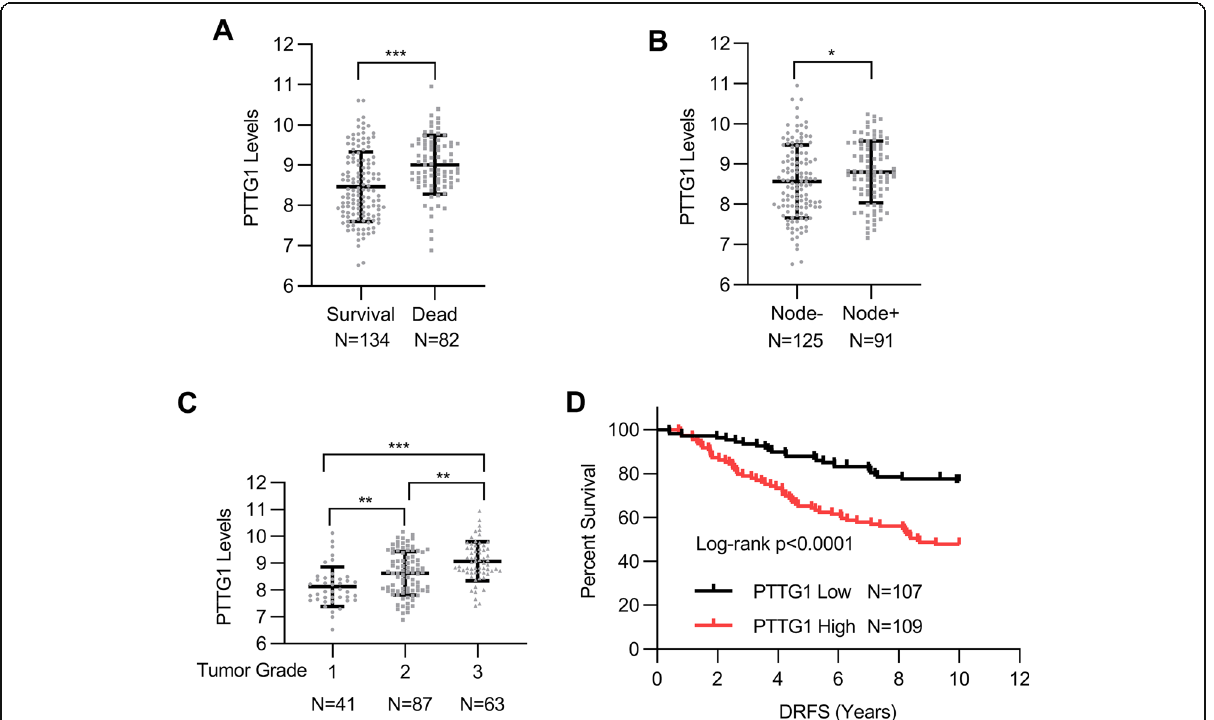
Fig. 1 The levels of PTTG1 were associated with poor survival rates in breast cancer. To analyze the relationship between PTTG1 and survival rate of patients with breast cancer, GSE22220 from the GEO dataset was applied. The dataset includes live and deceased cohorts according to the survival status of patients. The mRNA expression of PTTG1 was compared between live and deceased cohorts. a The mRNA levels of PTTG1 in survival patients and deceased patients. b The mRNA levels of PTTG1 in patients with or without lymphatic metastasis. c The mRNA levels of PTTG1 in patients with different tumor grades. d Kaplan – Meier plots were used to analyze stratification of survival rate in cancer patients according to their PTTG1 levels. Data were represented as mean ± S.D. * P < 0.05, ** P < 0.01, *** P < 0.001, ns indicates no